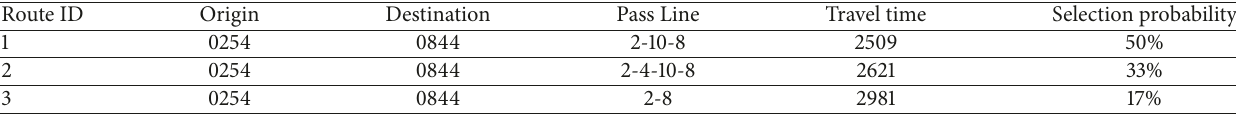
Table 5: Route list of the OD pair according to traditional model